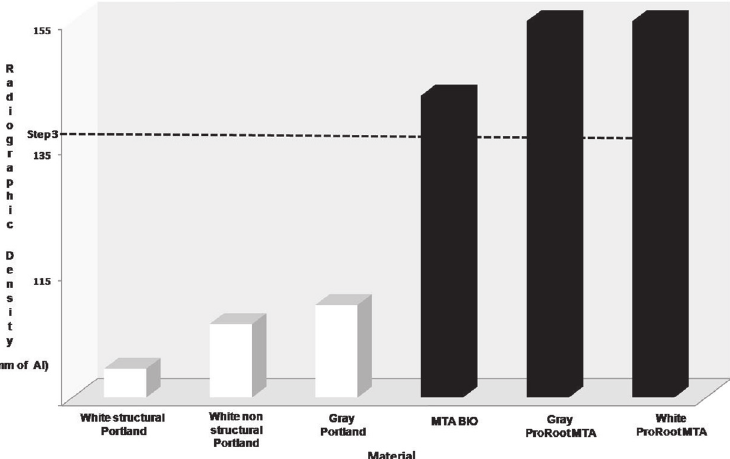
Figure 2- Experimental set-up used to fix x-ray machine central beam and the acrylic plates/phosphor plate set at a focus- object distance of 30 cm. In greater magnification, experimental set-up with the aluminium stepwedge, wells for root canal filling materials and radiography digital phosphor plate